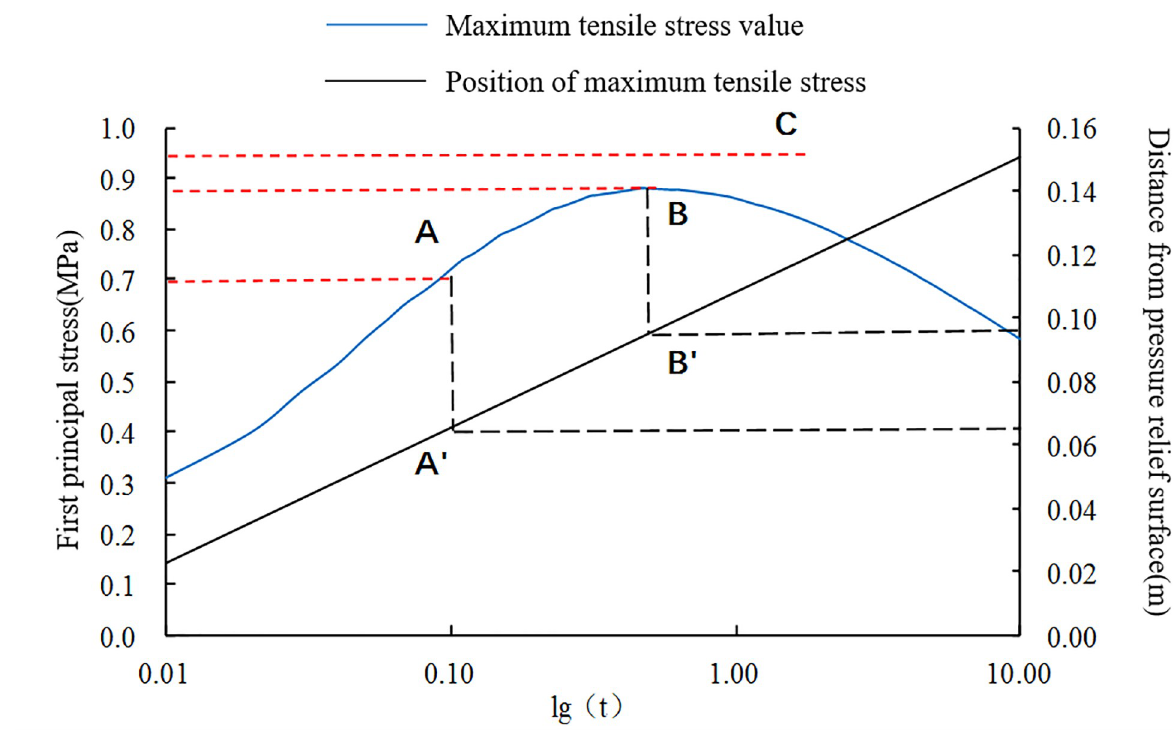
Fig 10. Simulation results of the maximum tensile stress and its position at different times after unloading.